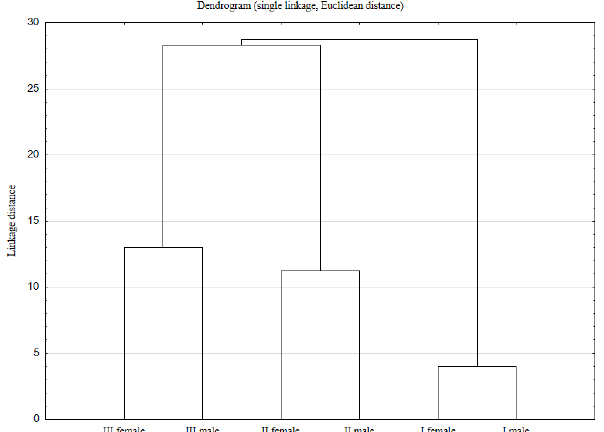
Figure 3. Complete-linkage dendrogram for female and male wild boars from different age groups (I piglets, < 1 year; II yearlings, 1–2 years; III adults, 2–3